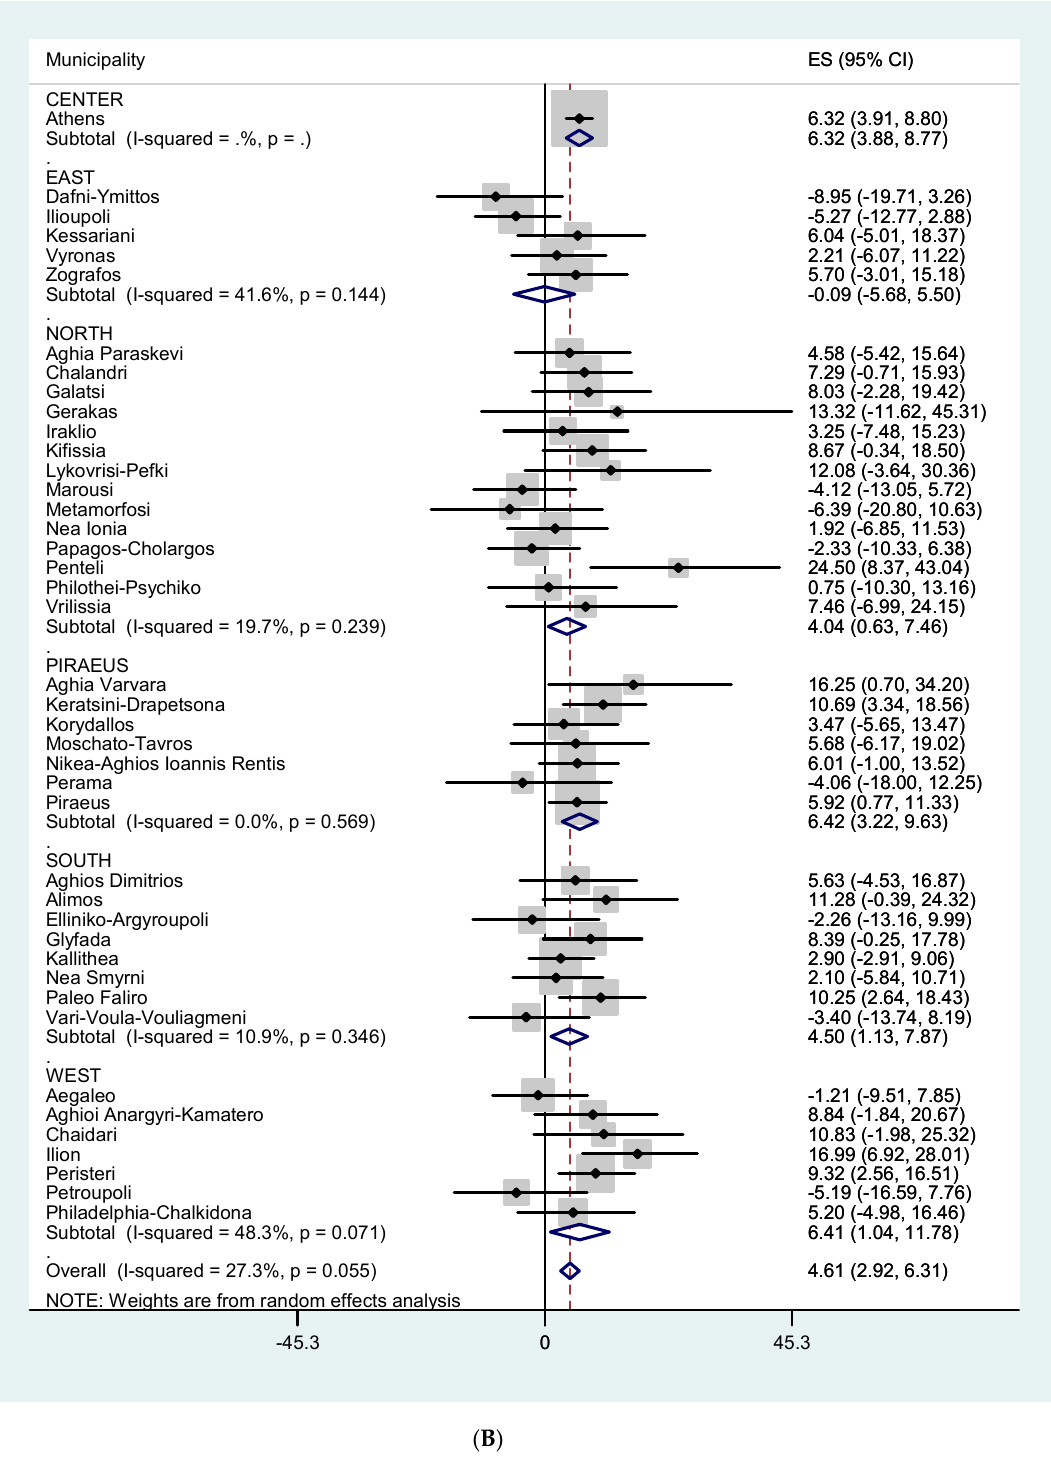
Figure 5B. ( A ) % increase in respiratory mortality, all ages, per 1 °C increase in maximum temperature Figure 5. ( A ) % increase in respiratory mortality, all ages, per 1 ◦ C increase in maximum temperature in in each municipality, using Thissio measurements and threshold of 31.5 °C. ( B ) % increase in each municipality, using Thissio measurements and threshold of 31.5 ◦ C. ( B ) % increase in respiratory respiratory mortality among the elderly (75+) per 1 °C increase in maximum temperature in each mortality among the elderly (75 + ) per 1 ◦ C increase in maximum temperature in each municipality, municipality, using Thissio measurements and threshold of 31.5 °C. using Thissio measurements and threshold of 31.5 ◦